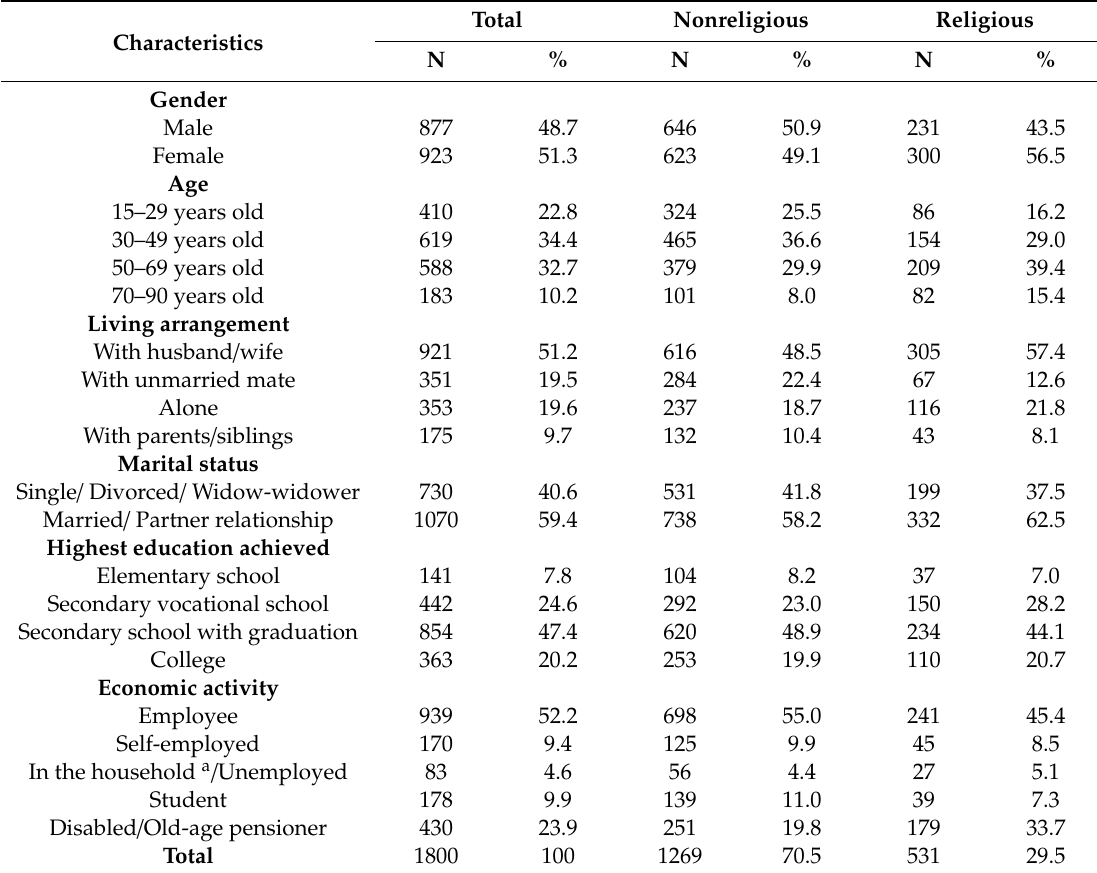
Table 1. Description of the study population, total and by